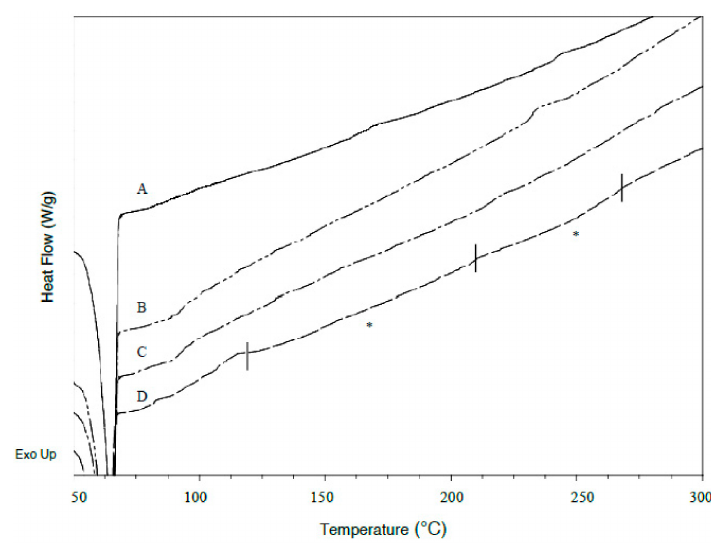
Figure 7. DSC thermograms of post-loaded DIC formulations. ( A ) PEO-DIC 3.28% w / w (25% saturation), ( B ) PEO-DIC 8.39% w / w (50% saturation), ( C ) PEO-DIC 13.62% w / w (75% saturation),